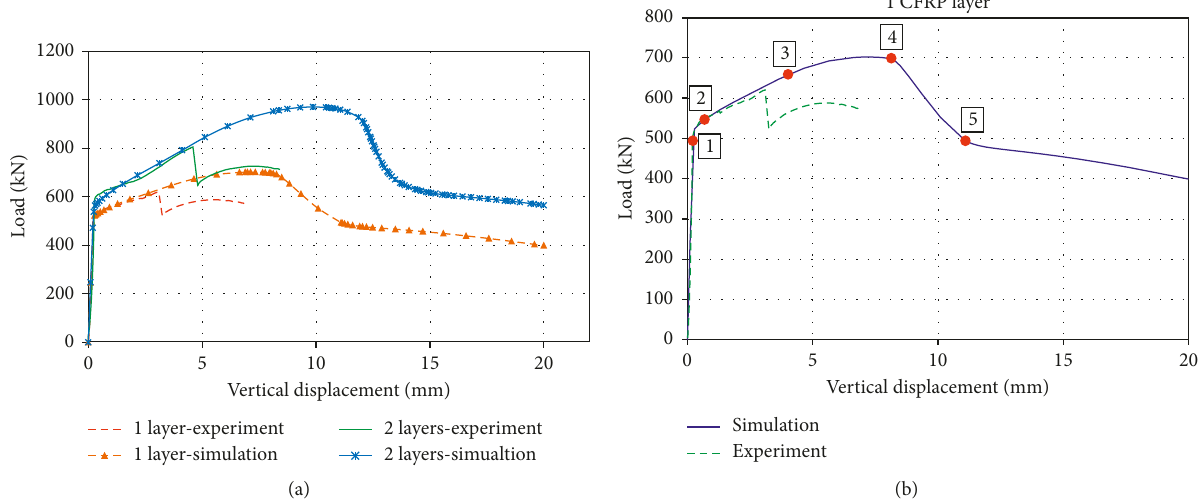
Figure 15: Numerical and experimental load/displacement curves.